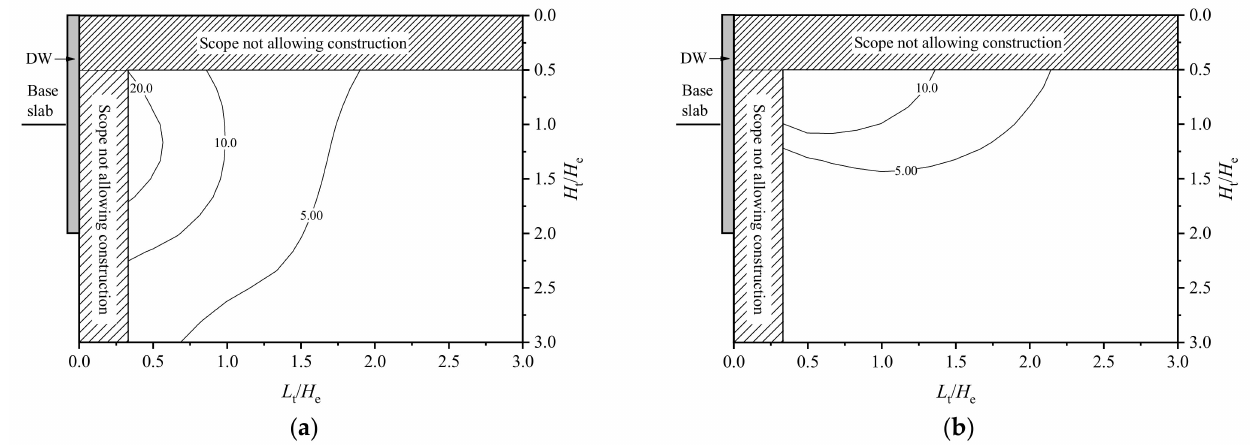
Figure 4. Influenced zones for tunnel displacements: ( a ) influenced zone for tunnel horizontal displacement; ( b ) influenced zone for tunnel vertical